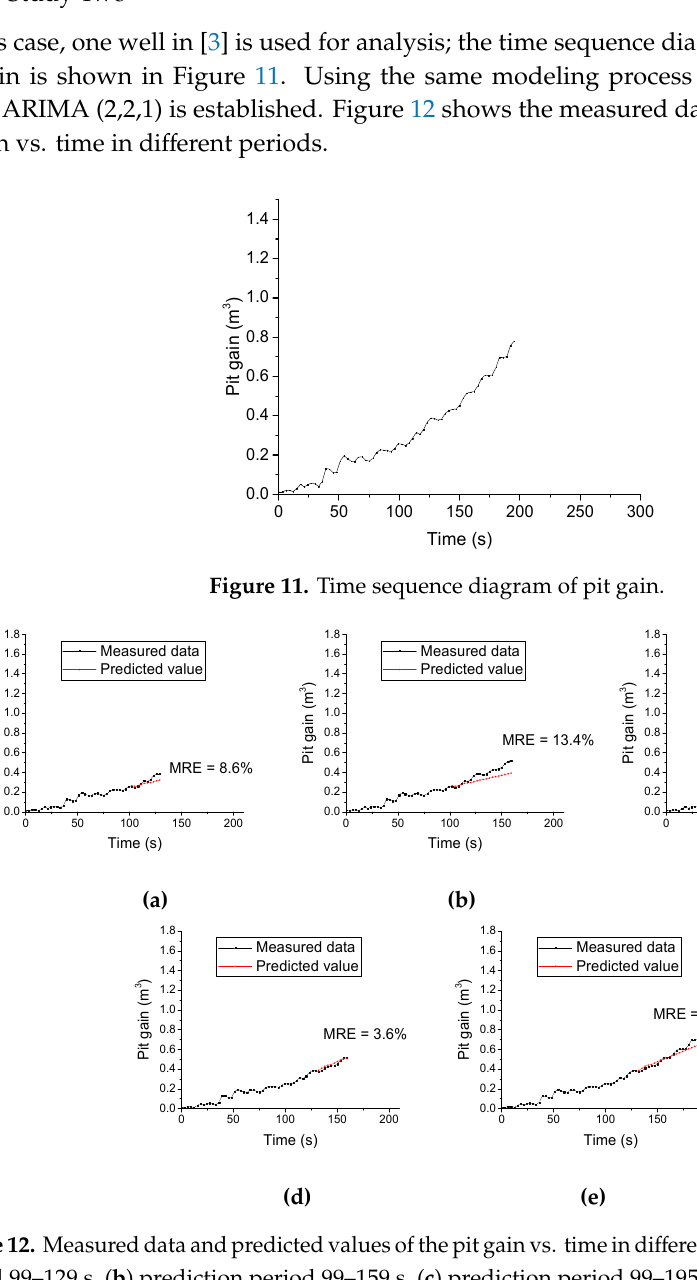
Figure 10. Kick severity analysis result using forecasted pit gain.